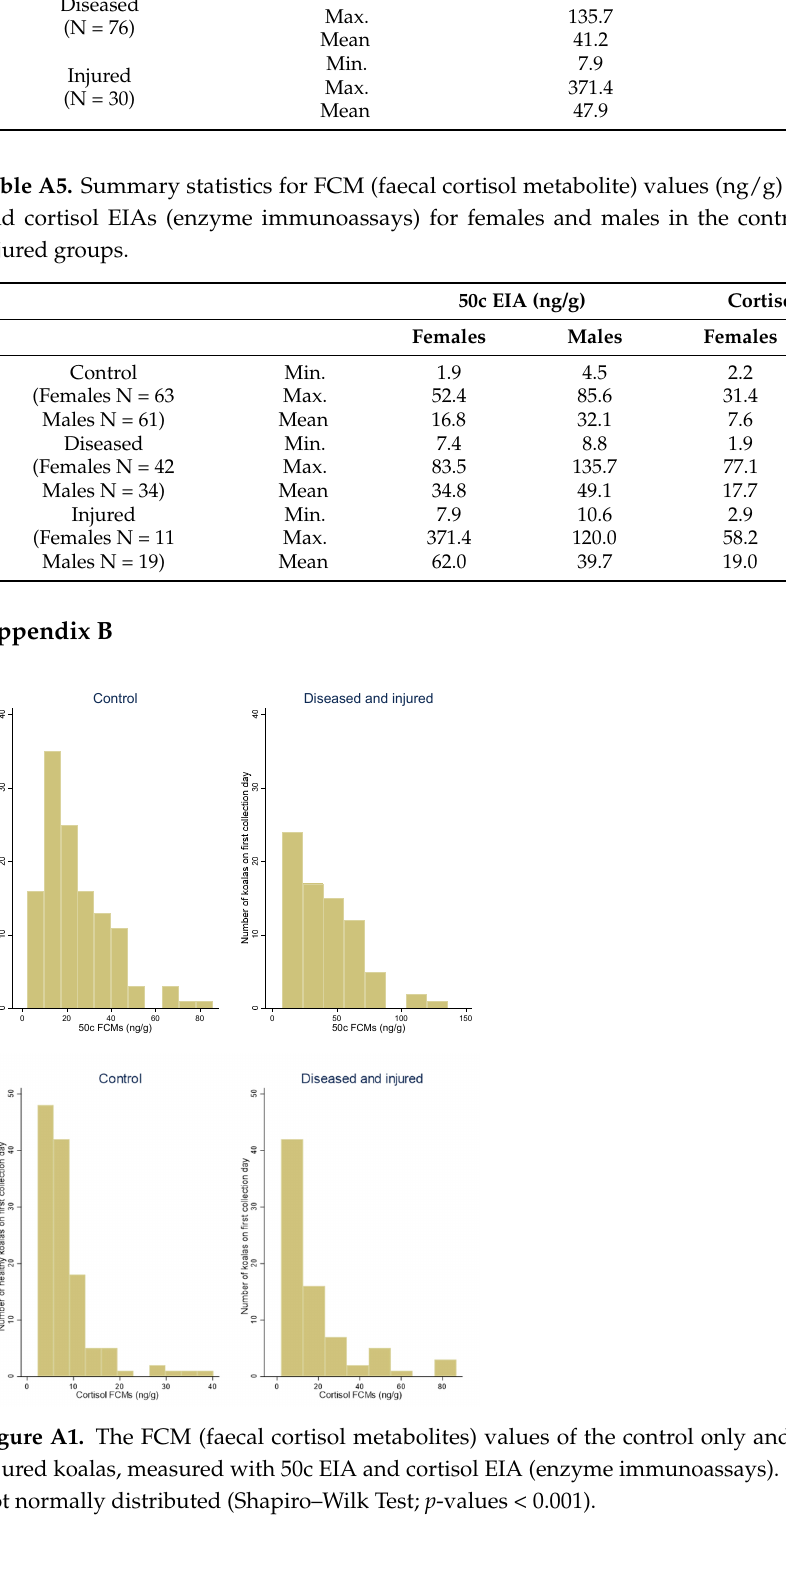
Table A4. Summary statistics for FCM (faecal cortisol metabolite) values (ng/g) measured by 50c and cortisol EIAs (enzyme immunoassays) for the control, diseased and injured groups. Group 50C EIA (ng/g) Min. Control Max. (N = 124)